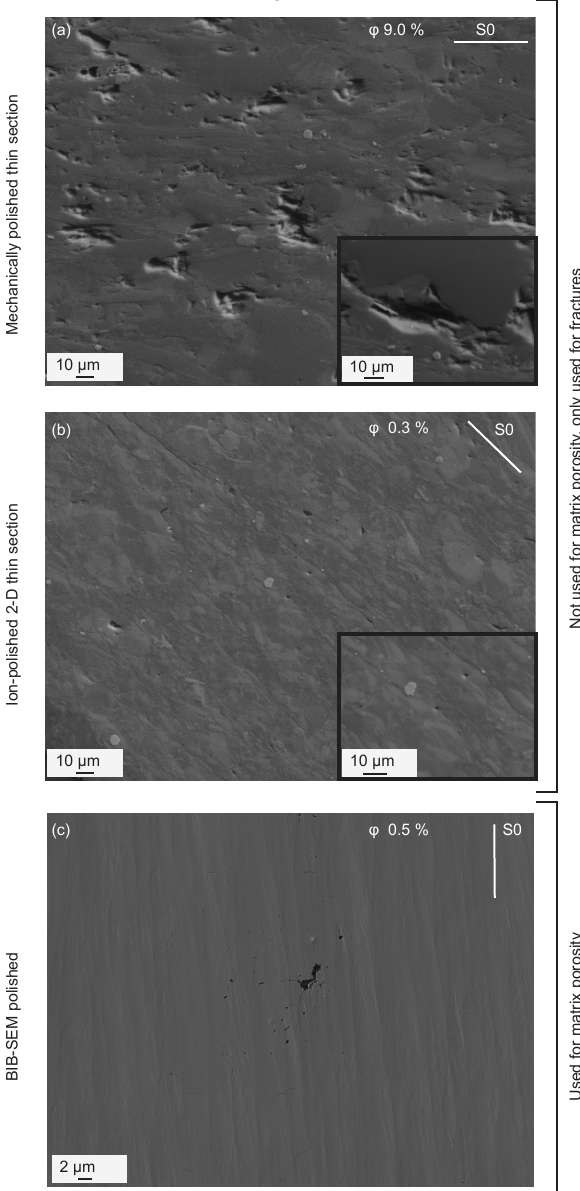
Figure 5. Differences in apparent porosity owing to applied sample polishing techniques in different samples. (a) Effect of conventional mechanical polishing of thin sections results in an overestimation of porosity owing to severe plugging of grains. (b) Ion-polished 2-D surface of sample taken at 46 ◦ 53 (cid:48) 17.2 (cid:48)(cid:48) N, 9 ◦ 07 (cid:48) 40.1 (cid:48)(cid:48) E shows a significantly smaller pore volume compared to the mechanical pol- ishing technique. (c) Smoothest surfaces with least induced pores created with BIB-SEM polishing. S0: